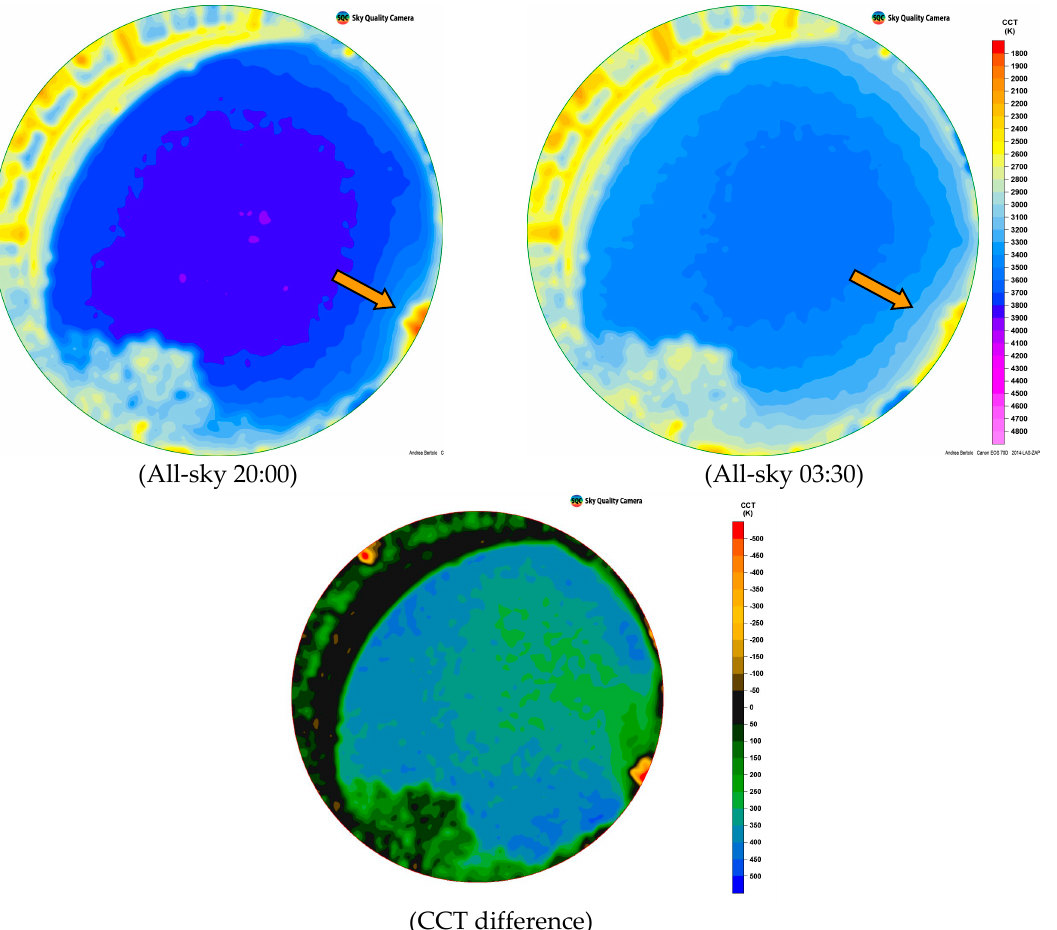
Figure 8. The upper row shows all-sky CCT images at Padova-Italy for a clear sky on 4 February 2019 at 20:00 local time and 5 February 2019 at 03:30 local time. The lower row shows the difference between CCT obtained from subtracting images. The orange arrow indicates Sant’Antonio s’ church.